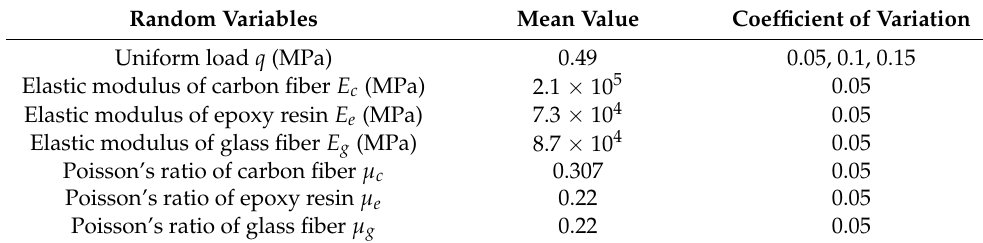
Table 5. The mean values and standard deviations for example 3.